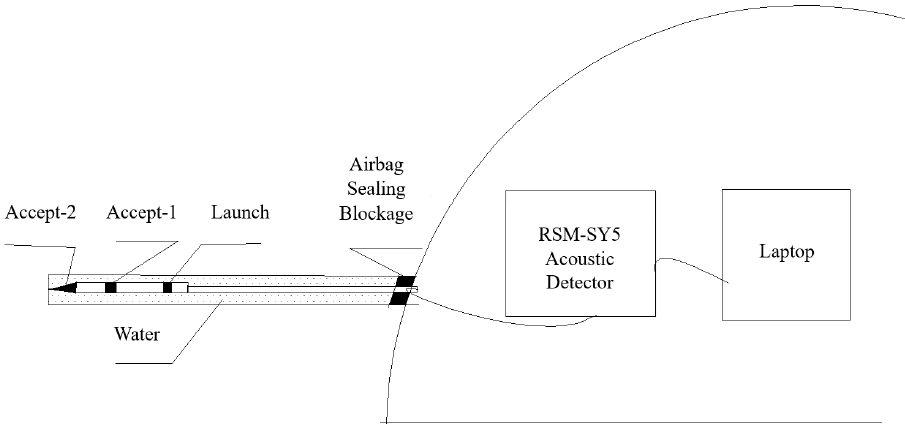
Figure 6. Schematic diagram of single-hole test by acoustic method.